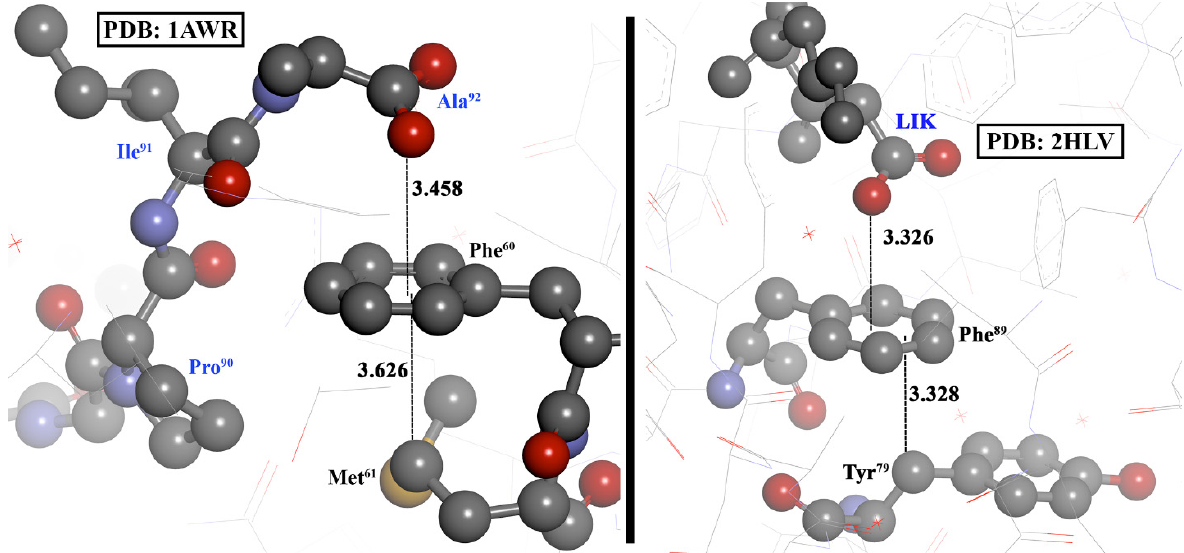
Figure 8. Partial views of X-ray structures of cellular protein cyclophilin A complexed with 87 HAGPIA 92 peptide ( left , PDB code 1AWR) and of triple mutant bovine Odorant Binding Protein complexed with 3,6-bis(methylene)decanoic acid, LIK ( right , PDB code 2HLV). Distances to the ring plane are given in angstroms. Carbon, nitrogen, oxygen, and sulfur atoms are indicated in grey, blue, red, and yellow color, respectively (hydrogen have been omitted for clarity).